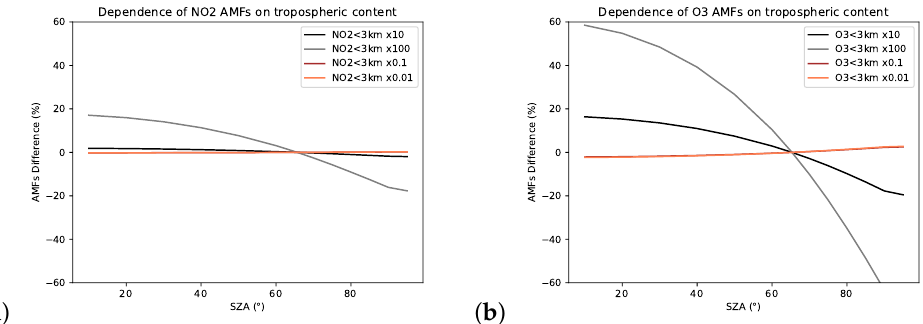
Figure 6. Percentage differences between AMFs computed using perturbed input profiles and standard profiles, for NO 2 ( a ) and O 3 ( b ). The AMFs simulated with standard profiles were the ones used to convert the SCDs into